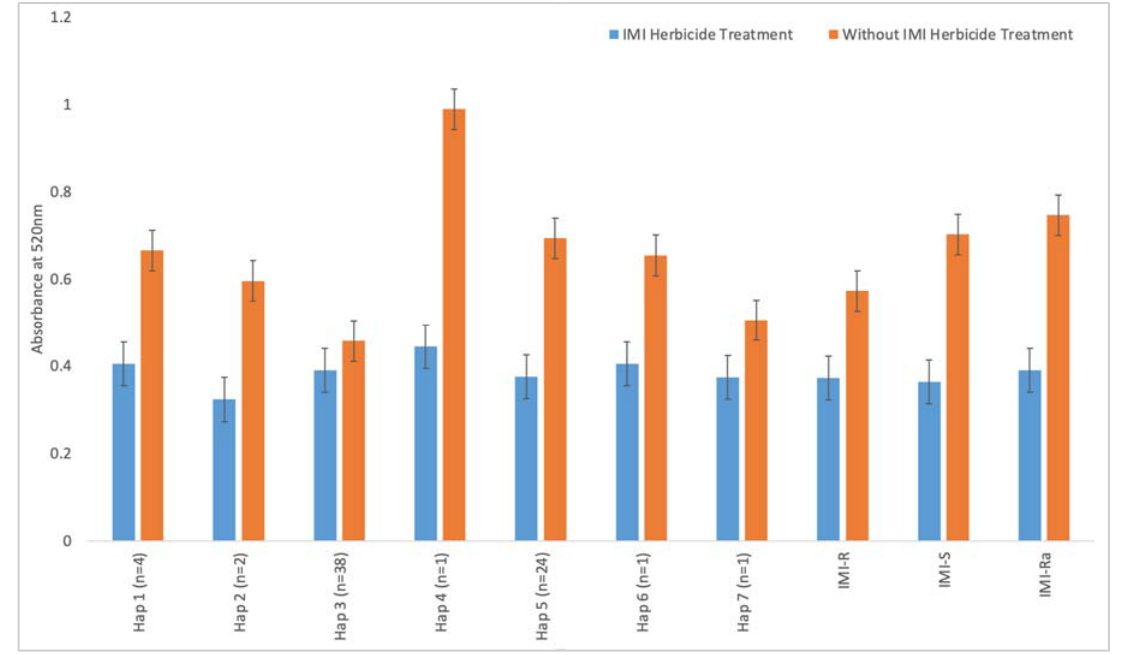
Figure 3. ALS enzyme colorimetric assay, with bar plots showing the absorbance reading of weedy rice samples at 520 nm. The letter “n” represents the number of samples in each haplotype group. IMI-R, IMI-S, and IMI-Ra represent the average absorbance reading of resistant, susceptible, and ambiguous samples, respectively.